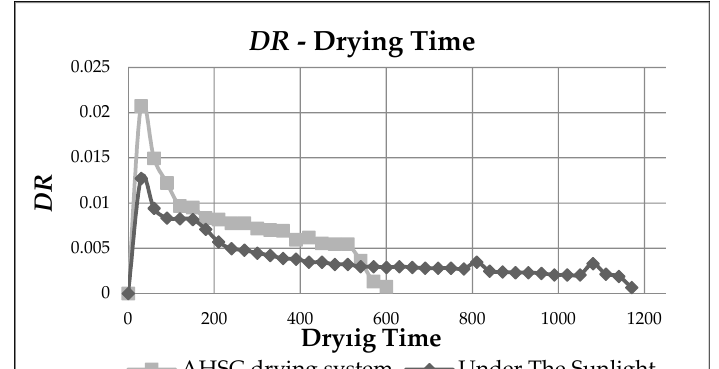
Figure 7. DR changing with drying time.